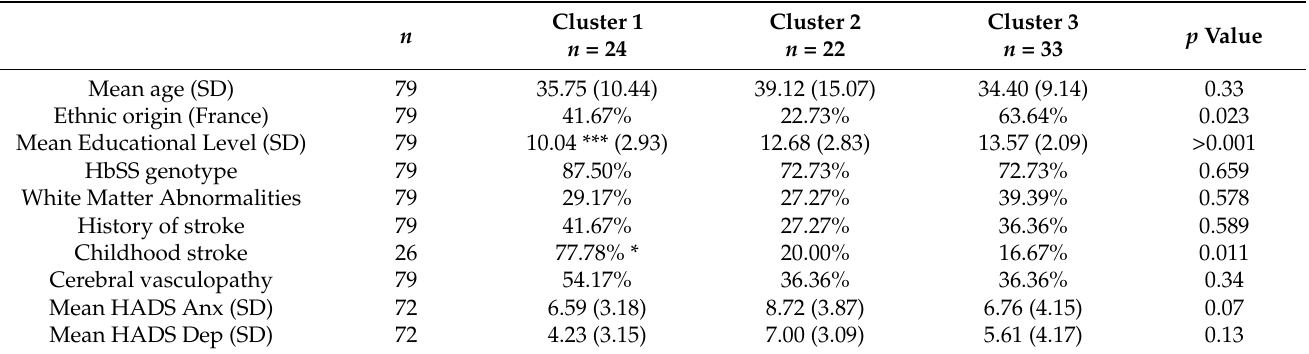
Table 5. Characterization of clusters in terms of different variables using Pearson Chi-square, ANOVA and post-hoc